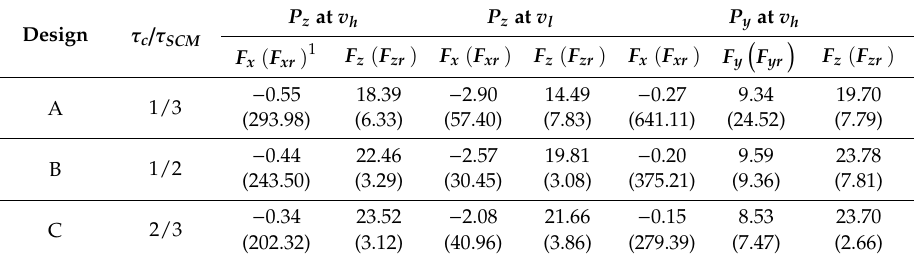
Figure 20. Drag, guidance, and lift force responses acting on the SCM driving v h in the P y position from ( a ) Design A, ( b ) Design B, and ( c ) Design C. Table 4. Average forces and ripples for comparing the design